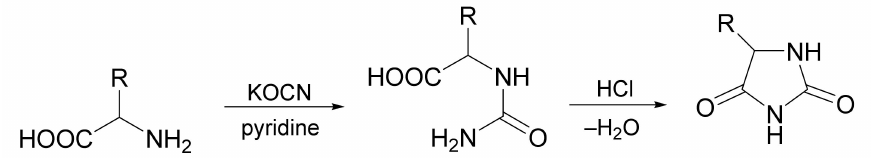
Scheme 23. General reaction scheme of the Urech hydantoin